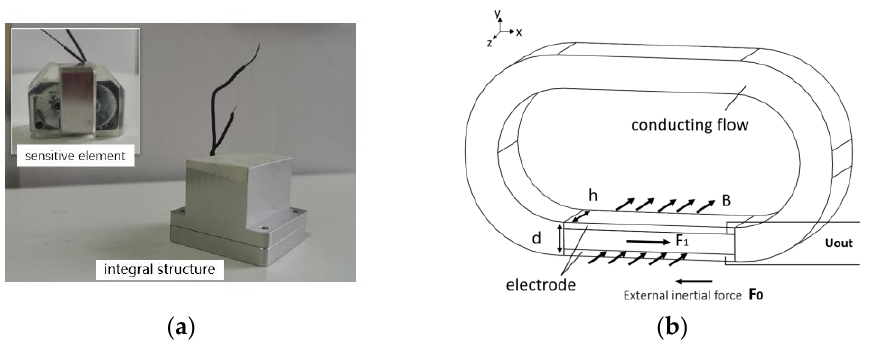
Figure 1. ( a ) The physical map of the quartz flexible accelerometer; ( b ) schematic diagram of the MHD linear vibration sensor